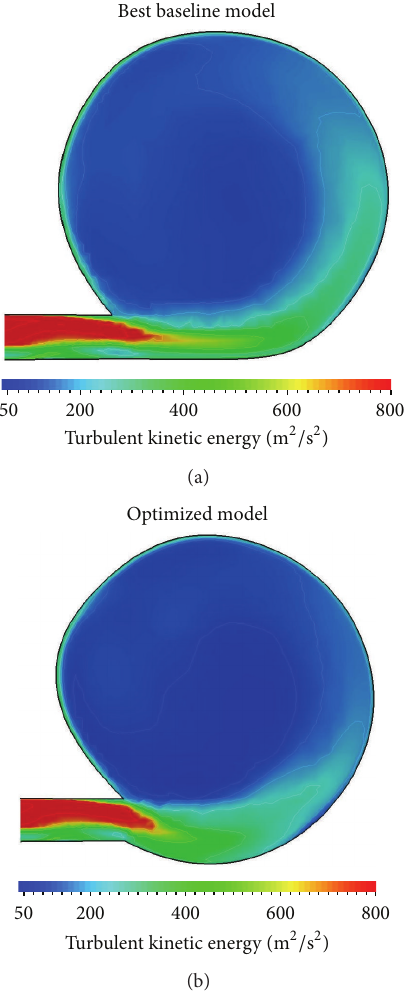
Figure 19: Turbulent kinetic energy at volute exit 𝜙 = 2𝜋 for the best baseline model (a) and optimized volute geometry (b) at ̇𝑚 corr = 0.19